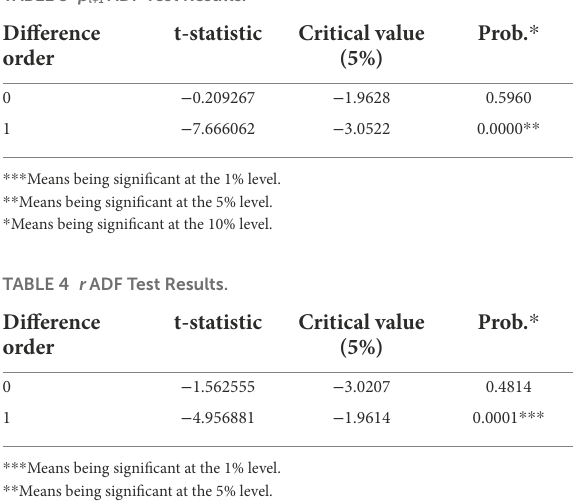
TABLE 3 p t+1 ADF Test Results.